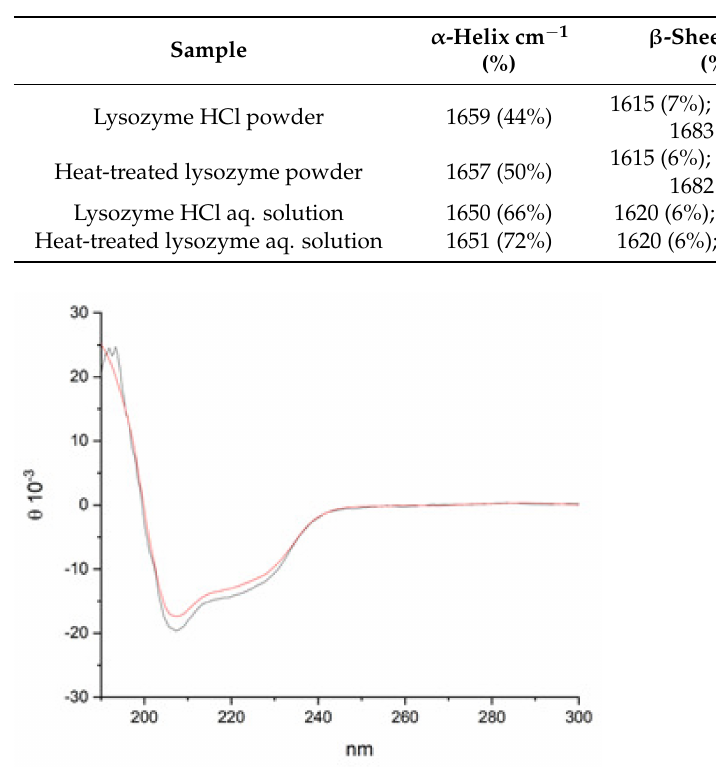
Table 2. Deconvolution results of ATR-FTIR analyses.